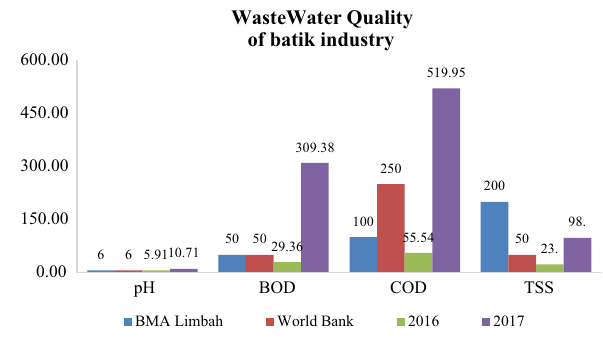
Fig. 2 Values of waste water quality from batik